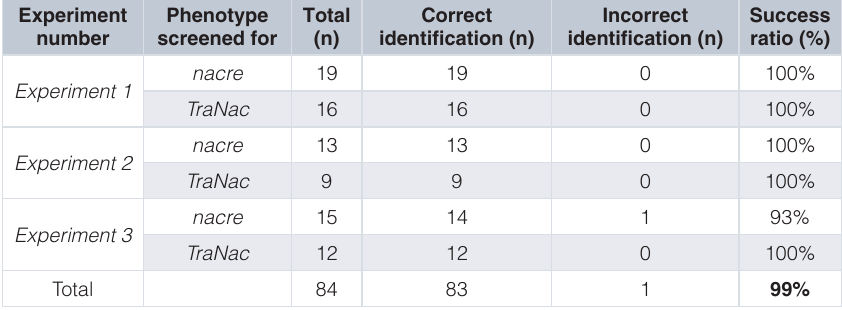
Table 1. Success rate of different screens for either nacre or TraNac